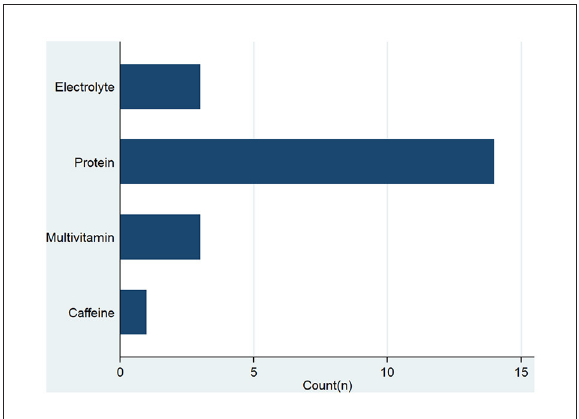
FIGURE1 Type of dietary supplements used by Taekwondo players.